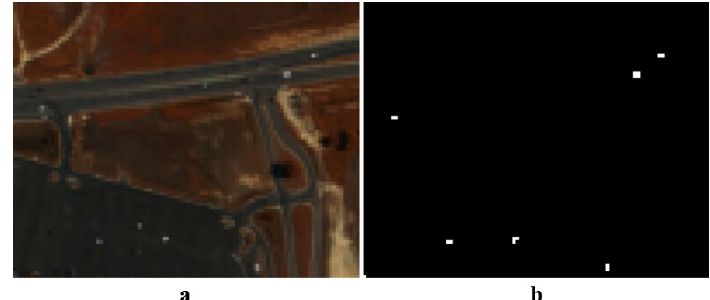
Figure 3. Second real-world data set: HYDICE urban scene. ( a ) False color image; ( b ) ground-truth map.